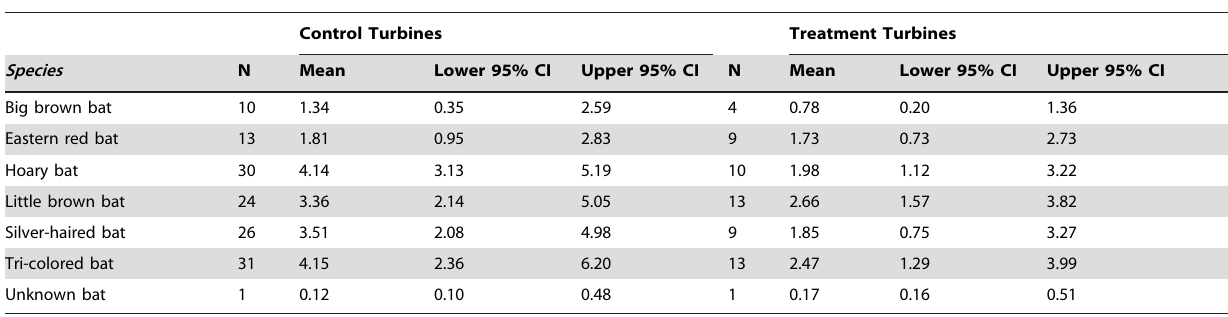
Table 4. Number of each species found (N) and the estimated bat fatalities/turbine (mean and 95% confidence intervals [CI]) for each species of bat per turbine, adjusted for searcher efficiency, carcass removal, and area, at control and treatment turbines at